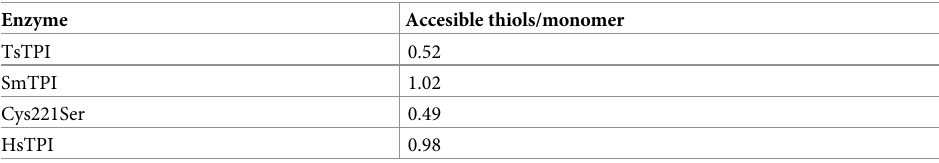
Table 3. Accessible thiol per TPI monomer in wild-type and mutant